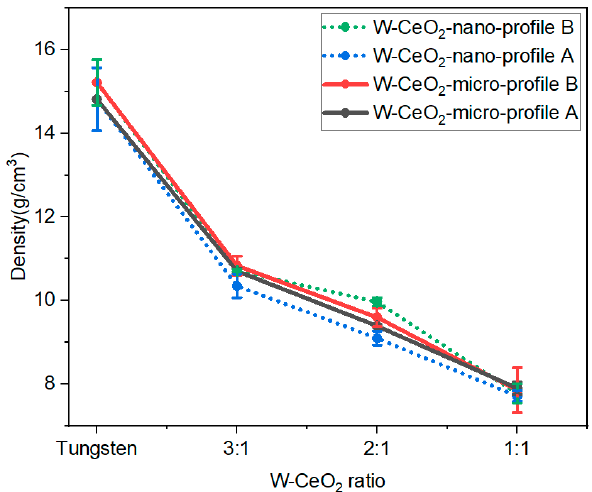
Table 1. HIP processing routes explored for the W-CeO 2 metal matrix composites and the resulting density, microstructure, and hardness.